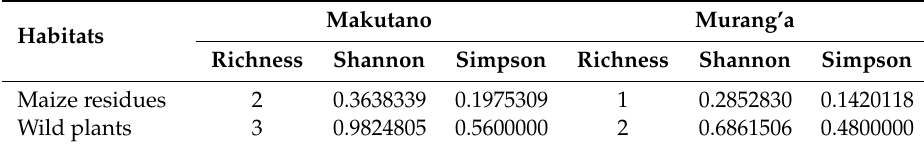
Table 5. Stemborer-associated parasitoid species diversity ranking of maize residue and wild plant habitats during non-cropping seasons in two di ff erent localities in the central region of Kenya.